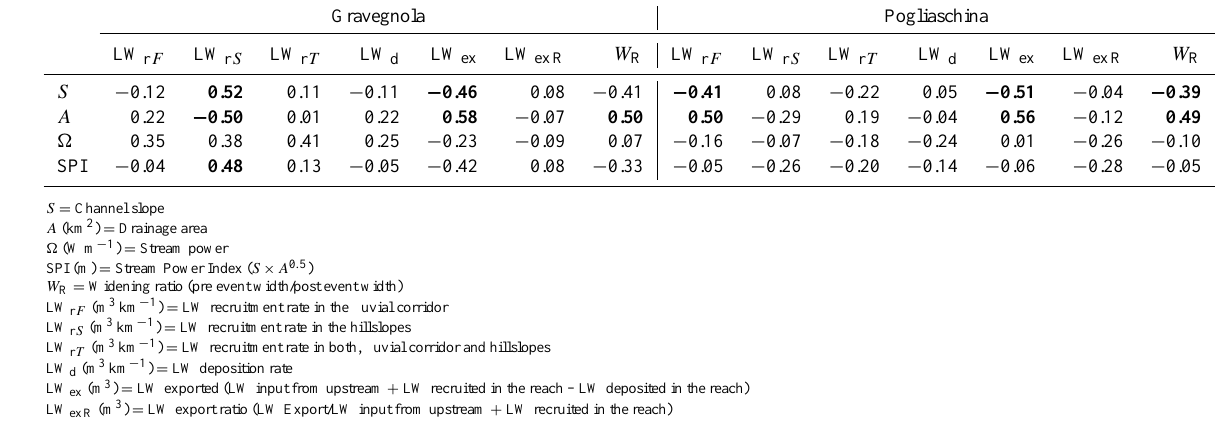
Table 3. Spearman correlation coefficients. In bold are correlations statistically significant ( p < 0.05). For symbols see the notation list. Gravegnola